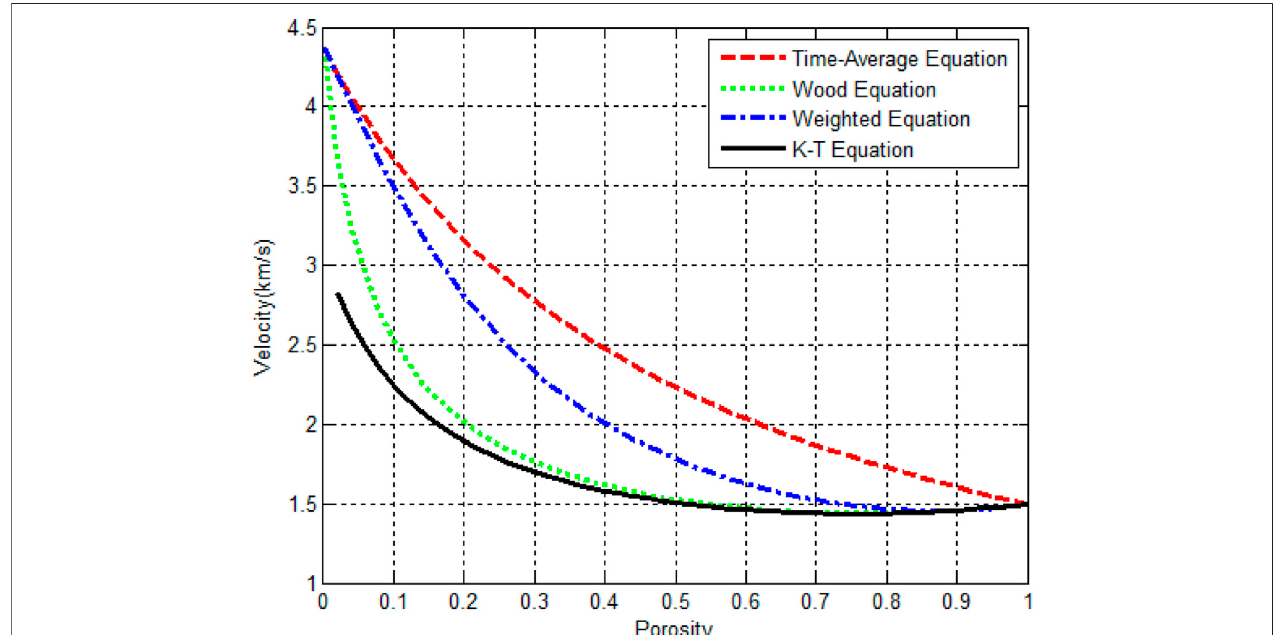
FIGURE 1 | Relationship between formation velocity and porosity without hydrate.